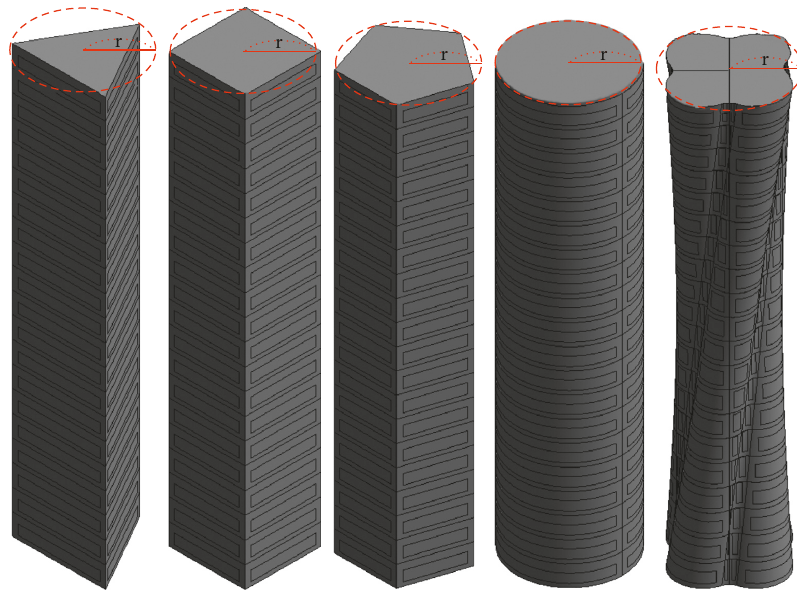
Figure 2: Energy model for analysis of form and window area ratio using